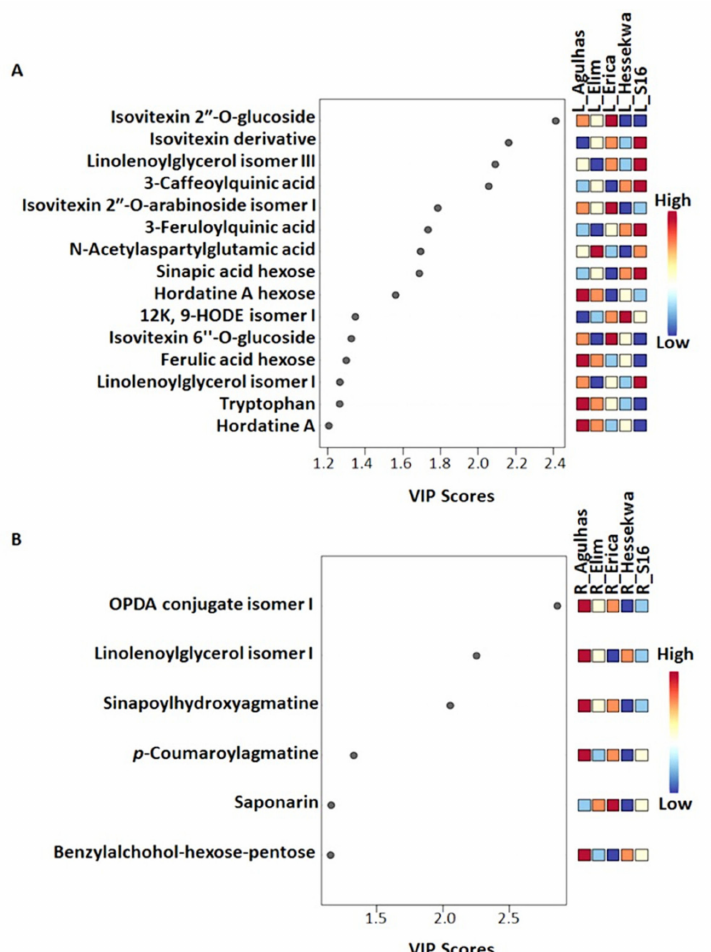
Figure 5. The most important discriminant metabolites (identified by PLS-DA) ranked by variable importance in projection (VIP) scores in component 1. The relative abundance of each important metabolite from leaf ( A ) and root ( B ) samples are indicated with a colour code scaled from blue (low) to red (high). The higher the VIP score, the higher the impact of the metabolite as a discriminant feature among the cultivars. Only the metabolites with a VIP score > 1 were